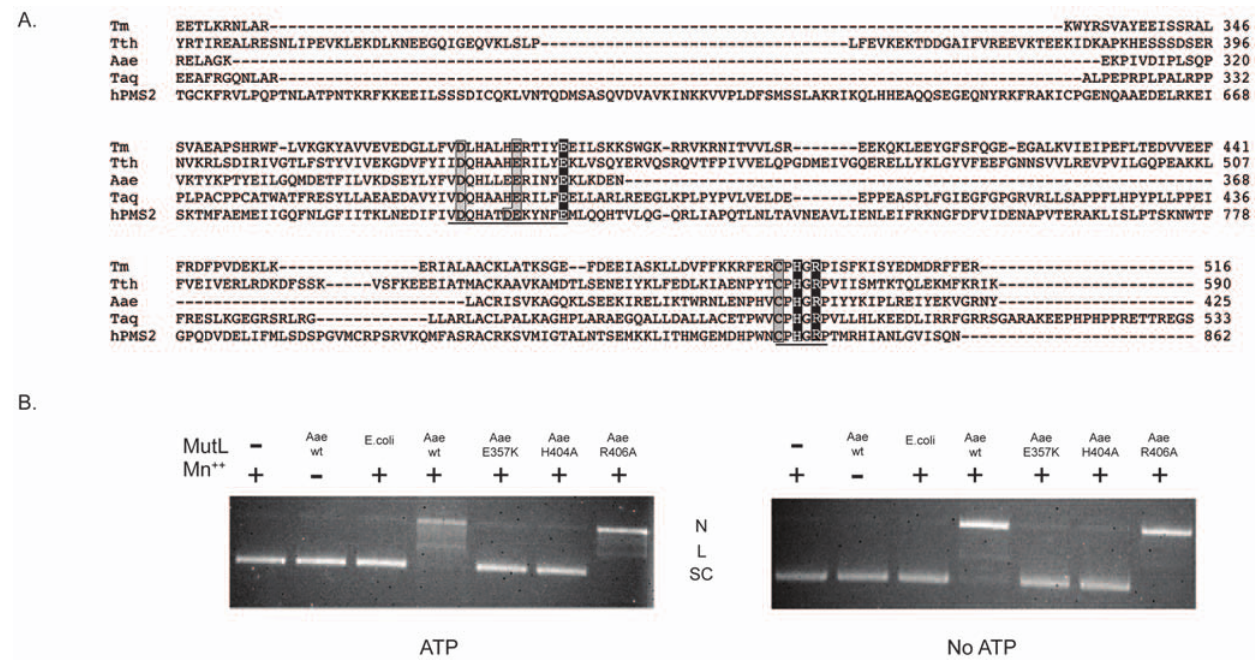
Figure 7. MutL homologue alignment and Aae MutL mutant activity. A, Alignment of the C-terminal amino acid residues of hPMS2 homologues (Tte= Thermoanaerobacter tengcongensis (NP_6622976), hPMS2=human (ABQ59090), Aae= Aquifex aeolicus (AAC07483), Taq= Thermus aquaticus (EED09553), Tm= Thermotoga maritima (AAB09596)). Two regions of high conservation are underlined. The white letters on a black background are the Aae MutL mutants described herein, E for E357K, H for H404A, and R for R406A. The mutations described previously are boxed. B, Endonuclease activities of wild-type and mutant Aae MutL and E. coli MutL on supercoiled pBR322 DNA were determined as described in the Materials and Methods. Mn ++ and ATP were included at 1 mM where indicated. The expected positions of supercoiled (SC), linear (L), and nicked (N) plasmid are indicated. Figure 1. One possible explanation for these observations would be that Aae MutL nicking activity is stimulated by ATP concomitant with a change in off rate or processivity.